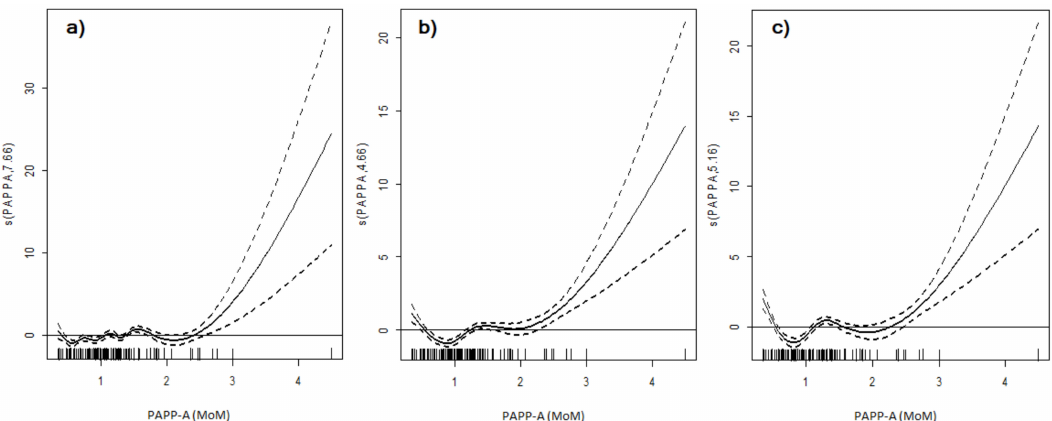
Figure 1. Generalized additive models of associations between PAPP-A concentration and preterm delivery (PTD) ( a ), delivery before 34 weeks ( b ) and delivery before 32 weeks of gestation ( c ) visualized as spline functions. ( a ): linear e ff ect p < 0.001, non-linear e ff ect p = 0.08; ( b ): linear e ff ect p < 0.001, non-linear e ff ect p < 0.001; ( c ): linear e ff ect p < 0.001, non-linear e ff ect p < 0.001. Vertical axis shows response values of logit (binomial) smooth spline function (“s” with name of the covariate, degrees of value). The bars in the bottoms of the figures present number of samples at each PAPP-A multiples of median (MoM)